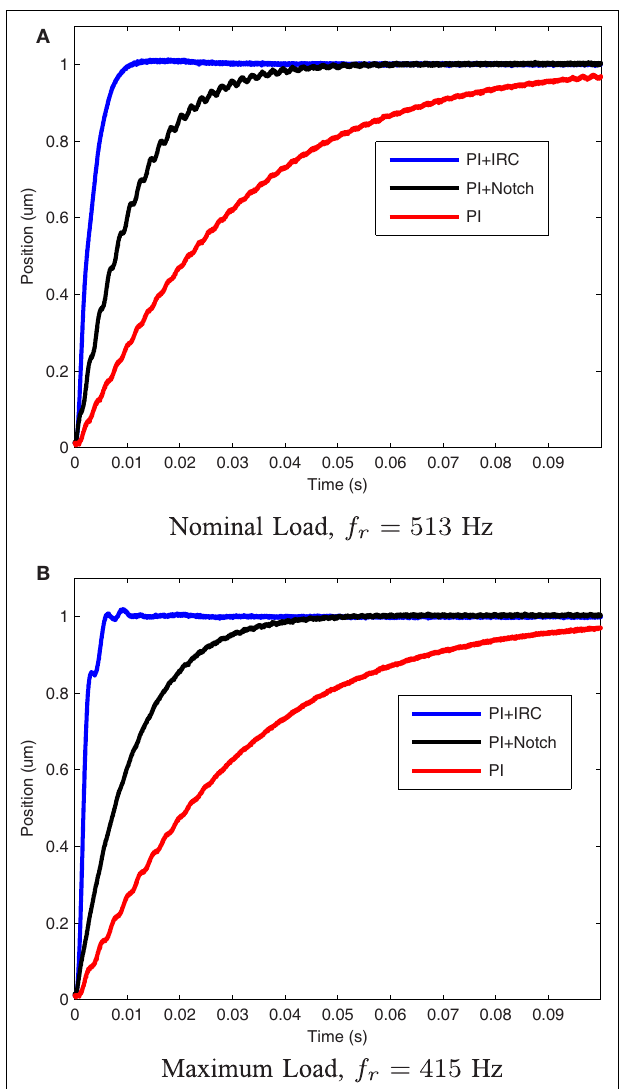
FIGURE 7 | The experimental closed-loop step response of each x -axis controller under nominal and maximum load conditions . The nominal response is plotted in (A) while the the perturbed system response is plotted in (B) .